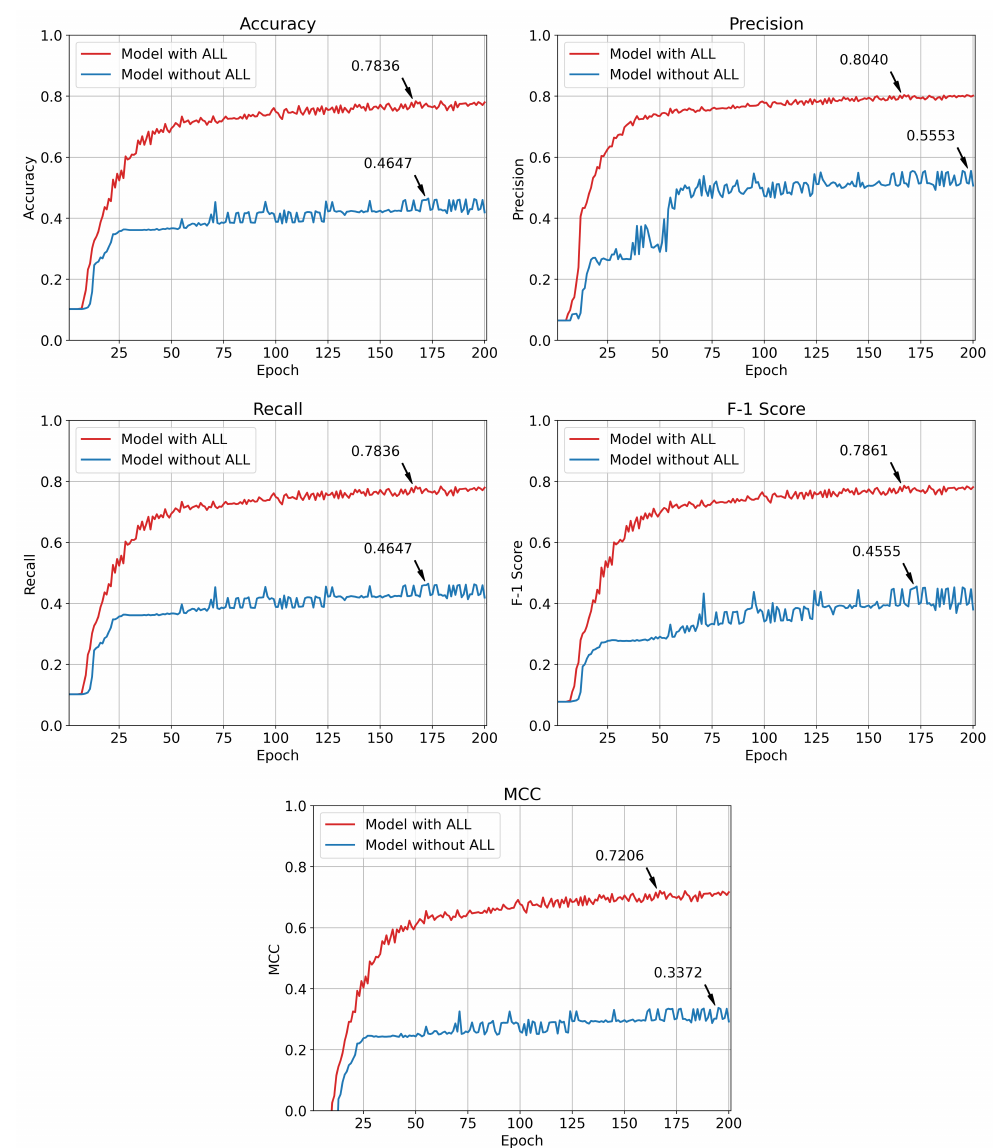
Figure 9. Model test performance comparison according to the attribute linear